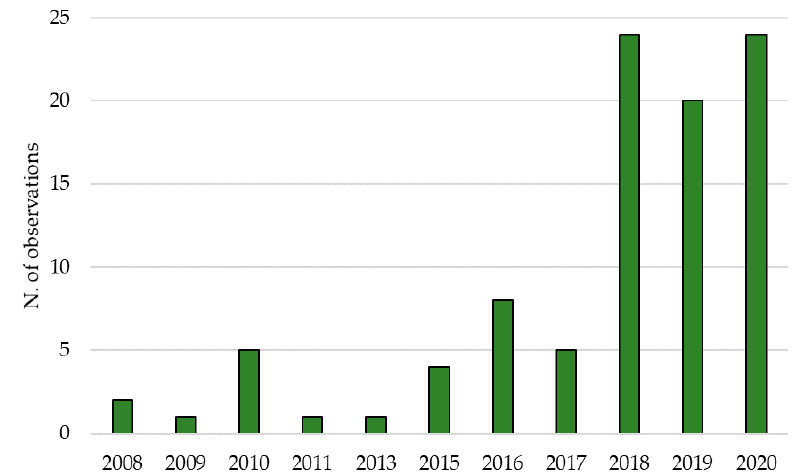
Figure 4. Frequency of the observations of the black weevil Aclees taiwanensis in Southern Europe since 2008. Based on the citizen-science data, the presence of the A. taiwanensis adults was con- firmed during the entire year (Figure 5).